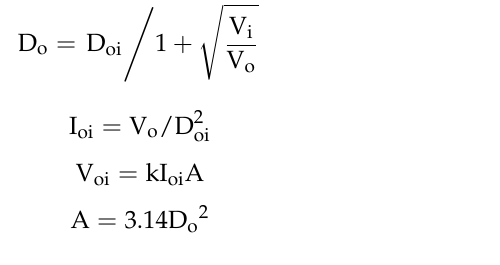
Table 5. Parameters and reference parameter values of breaking point model